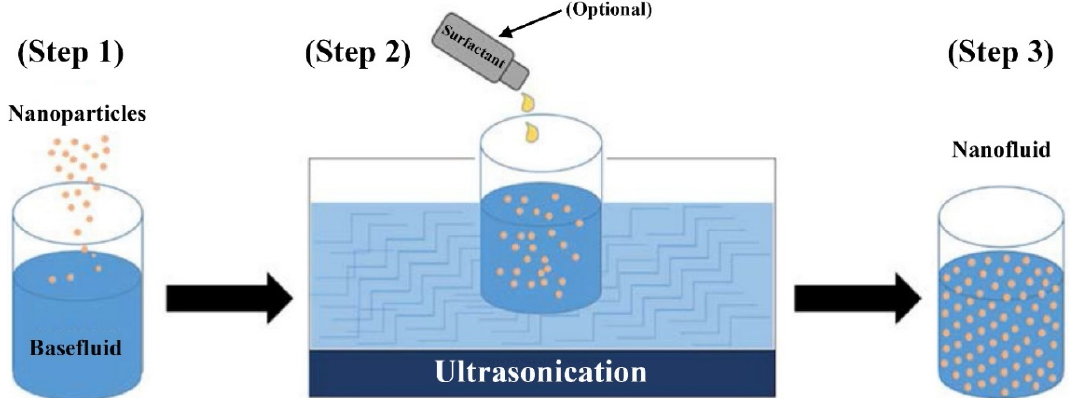
Figure 6. Illustration of the two ‐ step nanofluid fabrication method using an ultrasonicator device [158].